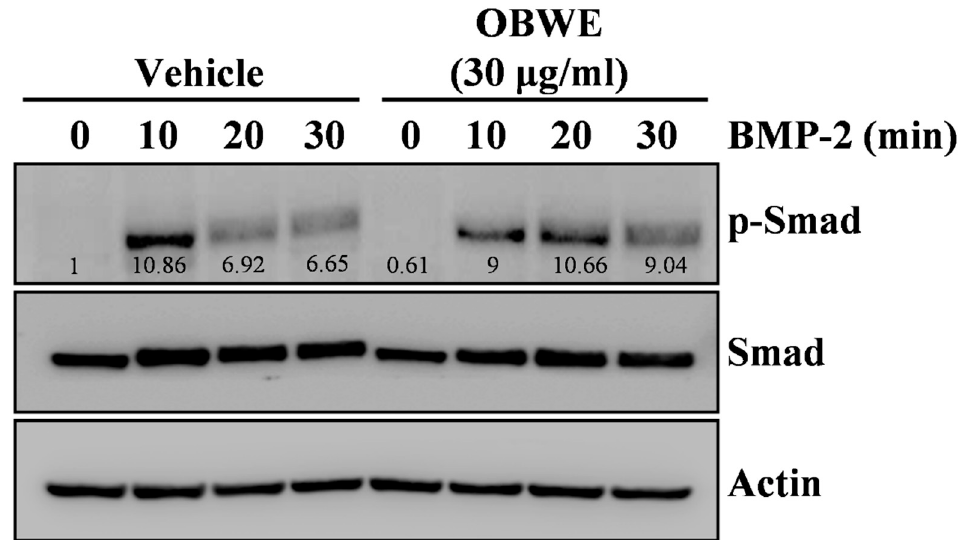
Figure 5. OBWE induces BMP-2–mediated phosphorylation of Smad signaling molecules. Following serum starvation for 1 d, C2C12 cells were pretreated with vehicle or OBWE (30 µg/mL) for 1 h prior to BMP-2 stimulation (100 ng/mL) for the indicated times. The expression levels of the signaling molecules were evaluated by Western blotting. Actin was used as the internal control.